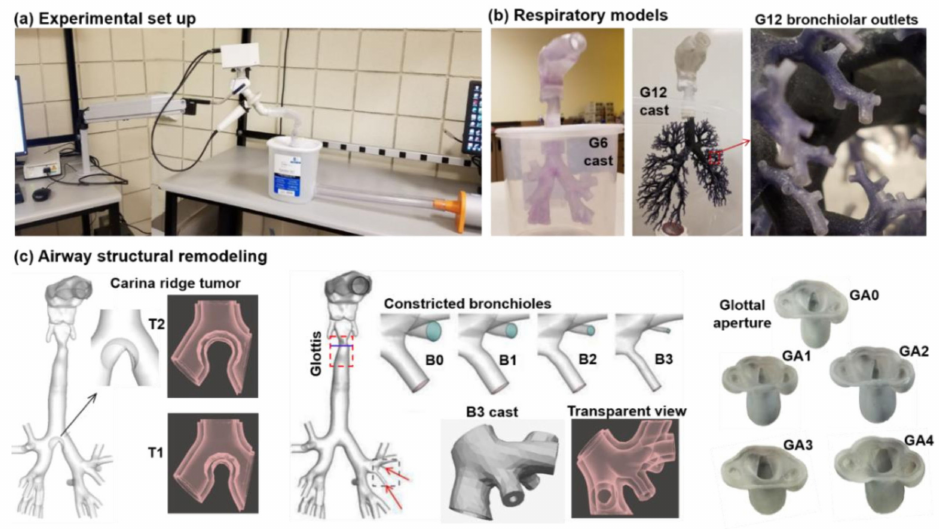
Figure 1. The impulse oscillometry (IOS) system and airway models: ( a ) the experimental setup consists of an IOS system, a respiratory model, and a syringe pump simulating cyclic breathing; ( b ) the model of the respiratory system consists of a mouth–throat hollow cast, a conducting lung cast that retains branches up to either G6 (i.e., the sixth bifurcation generation) or G12, and a container simulating lung parenchyma; and ( c ) the airway obstructions considered herein include carina ridge tumors (T1 and T2); constricted segmental bronchi (B1, B2, and B3) in the left upper lobe, and varying glottal apertures (GA1, GA2, GA3, and GA4), each group in contrast to the control case